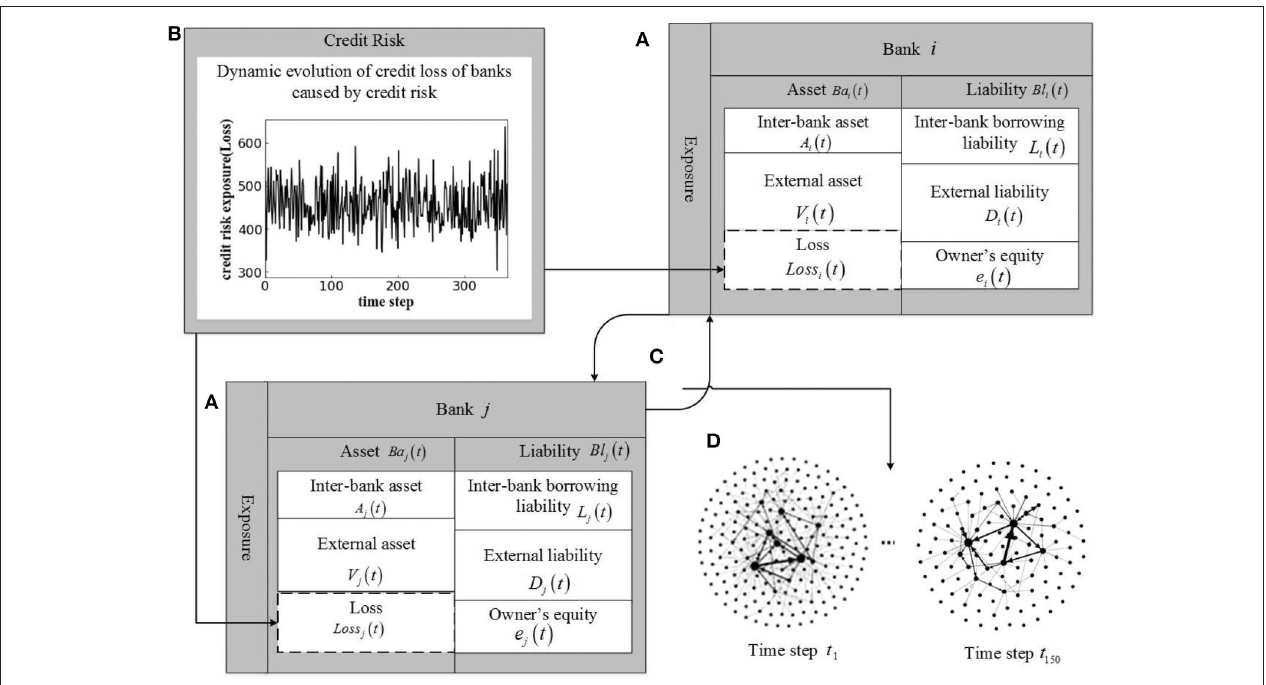
FIGURE 1 | A dynamic evolution model of bank systemic risk assessment under double risk exposures. (A) Represents dynamic evolution of bank balance sheet structure of bank i and j . (B) Plots the dynamic evolution curve of credit loss of banks caused by credit risk of the real industry. (C) Represents interbank market risk exposure. (D) Shows dynamic evolution of interbank market network structure from time step t 1 to time step t 150 .